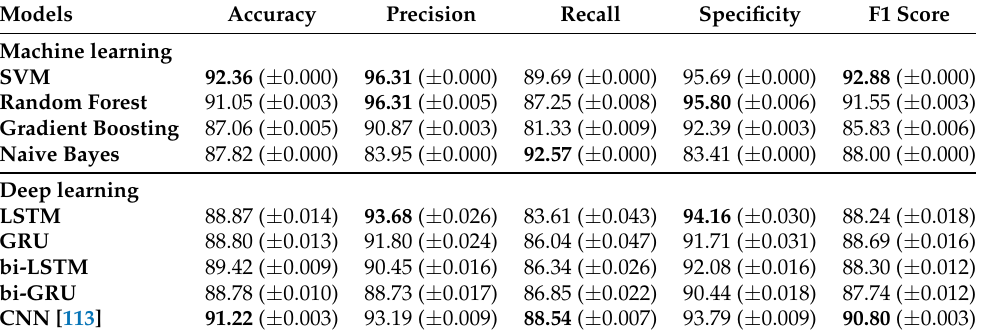
Table 5. Evaluation of proposed models regarding accuracy, precision, recall and F1 score (in % with its respective standard deviation) when applying text preprocessing techniques. Please note that the Random Forest and naive Bayes models presented a very low standard deviation, and thus it is represented as zero.